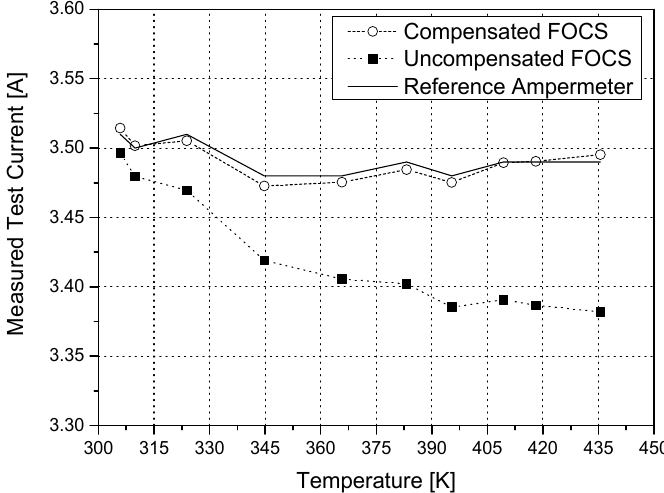
Figure 4. Current in the Helmholtz coils sensed by the reference ampermeter, the uncompensated FOCS, and the temperature compensated FOCS.